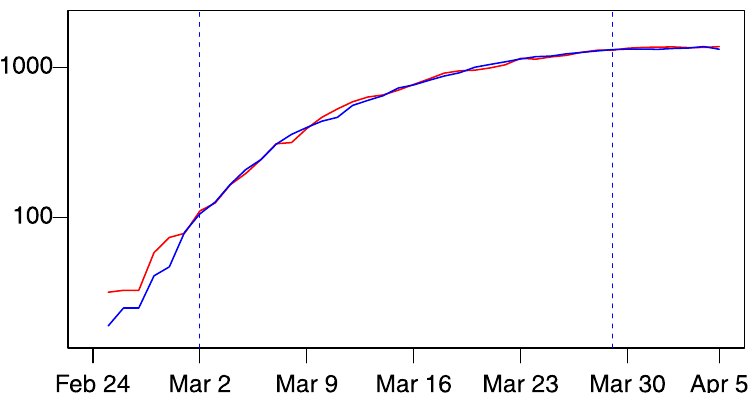
Fig 2. Actual ic t (blue) and fitted values 0.74 hws t − 1 + 0.24 (red) from the first stage regression of the d (1, 1) model for Lombardy, estimation period February 28–March 29, 2020. The graph also includes the out-of-sample periods of February 24 to March 1 (pre-estimation period) and from March 30 to April 5, 2020, where these periods are separated by vertical dashed lines.